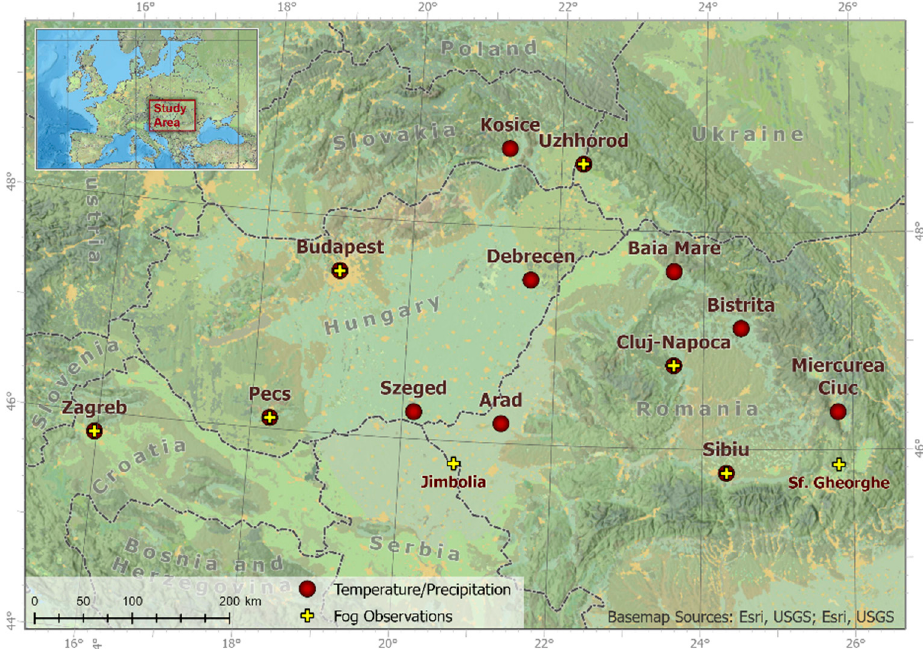
Figure 1. The study area. The historical meteorological stations in the Carpathian Region considered in the study. Stations shown by red color had continuous temperature and precipitation observations, while those marked in yellow had observations for fog.